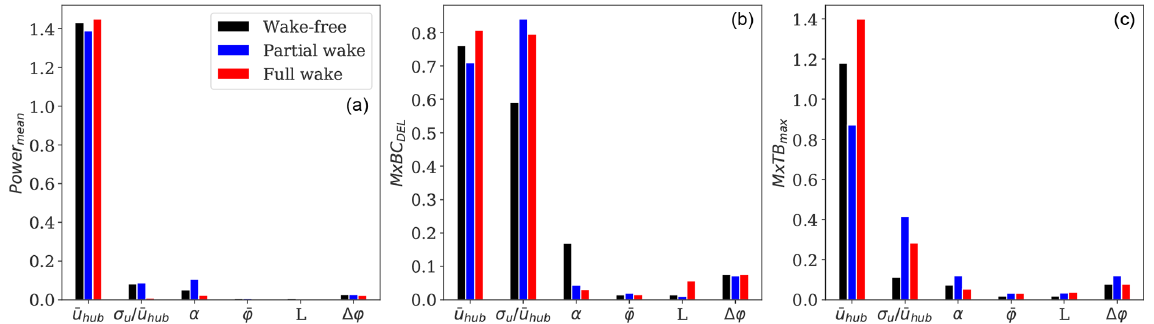
Figure 10. Regression coefficients of a linear response surface model identifying the sensitivity of wind field parameters to (a) mean power production, (b) fatigue flapwise bending moment at the blade root, and (c) extreme fore–aft tower bottom bending